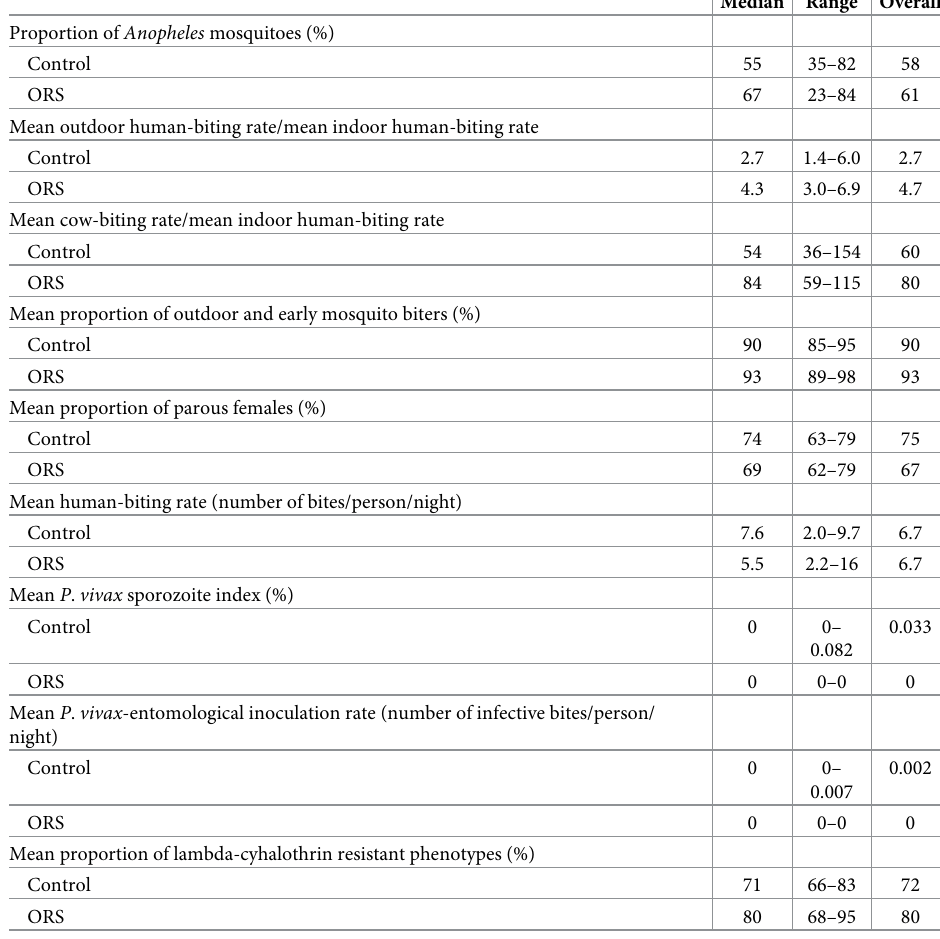
Table 3. Baseline characteristics of the entomological indices in the villages of the ORS and no intervention (con- trol)